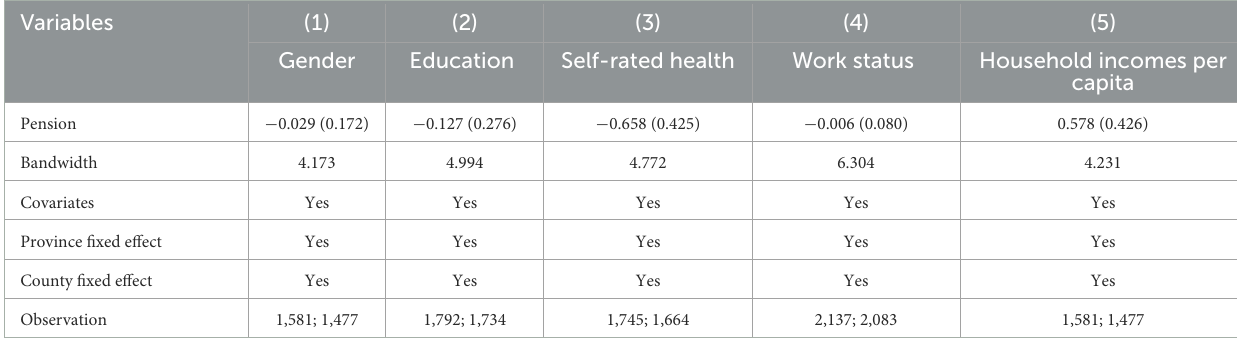
TABLE 5 The results of the continuity check of each covariate at the cutoff.